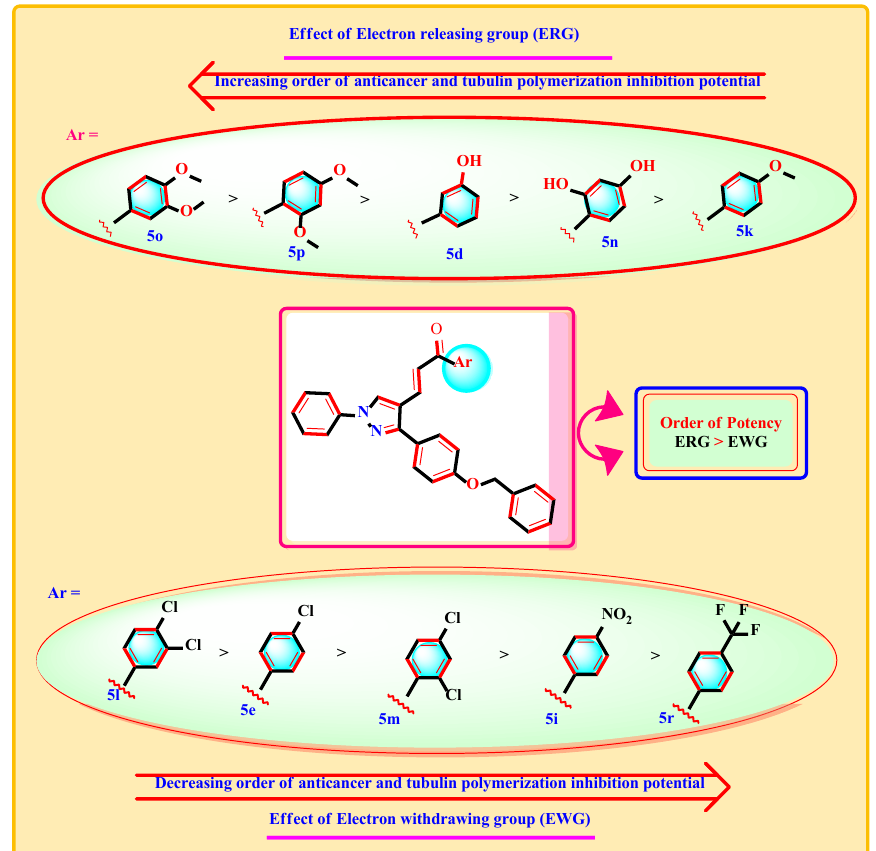
Figure 6. SAR of titled compounds.